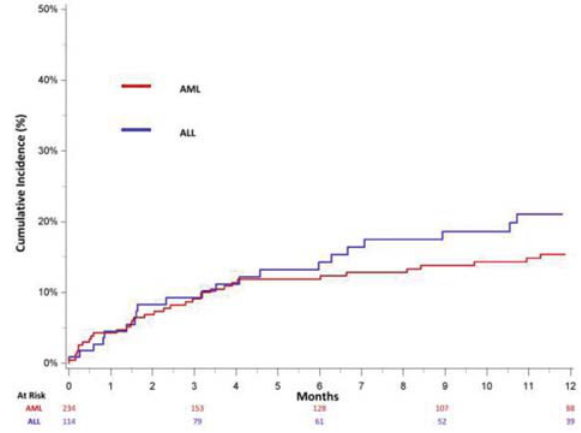
Fig.3 Cumulative incidence of subsequent bleeding, adjusted for the competing risk of subsequent VTE and death, among treated Cal- ifornia acute leukemia patients with an upper extremity deep vein thrombosis, 2009 to 2014. AML, acute myeloid leukemia; ALL, acute lymphoblastic leukemia; VTE, venous